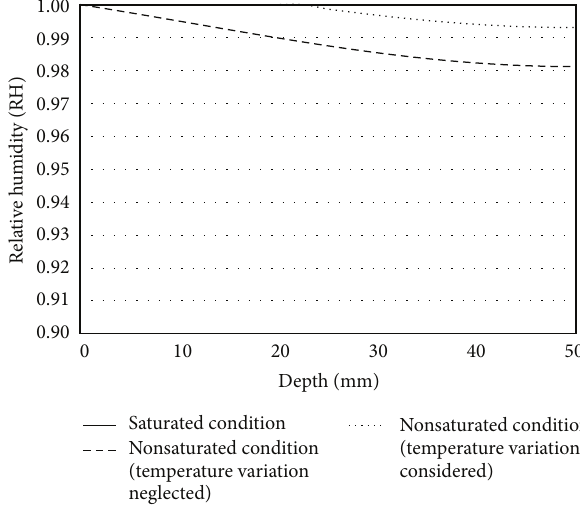
Figure 2: Moisture profiles at 10 days of exposure.